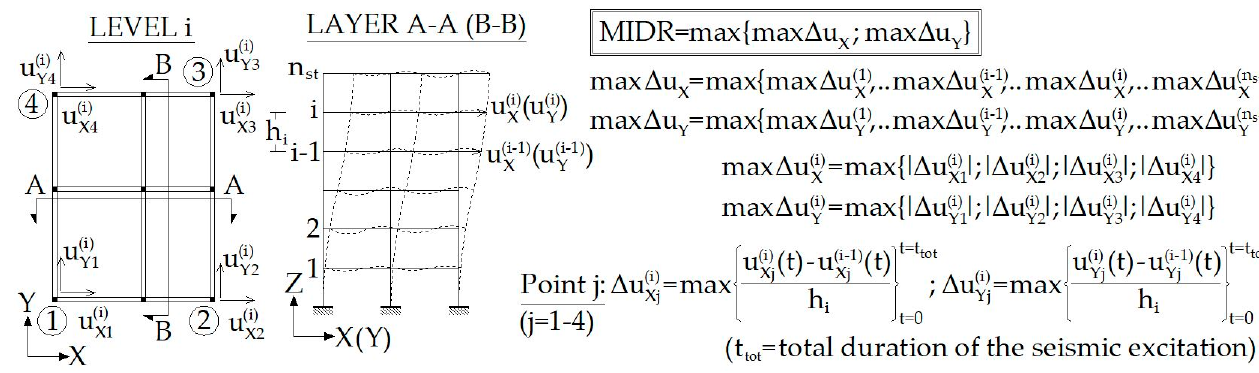
Figure A3. ( a ) Moment (M)–Rotation ( θ ) relationship and ( b ) N–M 2 –M 3 interaction diagram. Regarding the evaluation of the used damage index MIDR (which corresponds to the maximum drift among the perimeter frames), the post-processing of the NTHA results leading to the calculation of its values is summarized for the case of an n-story building with an arbitrary plan view in Figure A4.